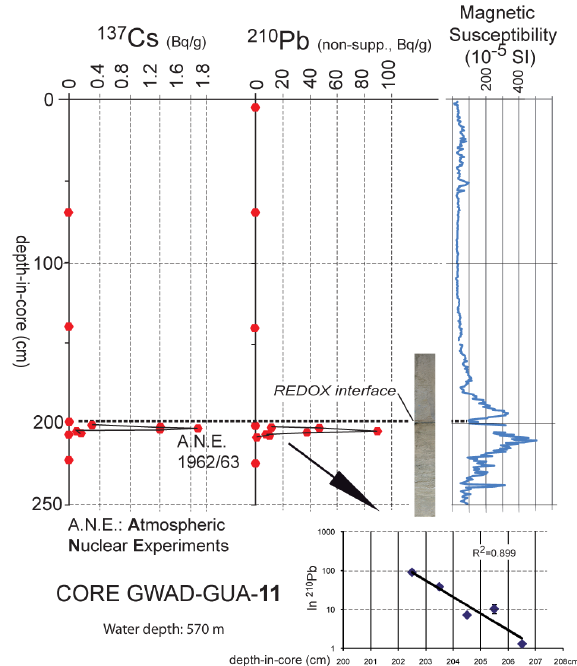
Fig. 8. Radionuclides and magnetic susceptibility profiles of Core GWAD-GUA 11. The radionuclides activities indicate that the yel- lowish level between 200 and 215cm represents the recent RedOx interface of a slow hemipelagic sedimentation. The overlying 2m of homogenous silty sand (referred within text as Topmost Sandy Ho- mogenite/TSH) recently capped this RedOx interface; its thickness is much higher than the resolution of the used seismic imaging. The 210 Pb decrease (ln. 210 Pb activity vs. depth; lower graph) is similar to Core GWAD-GUA 12’s profile (Fig. 6b).